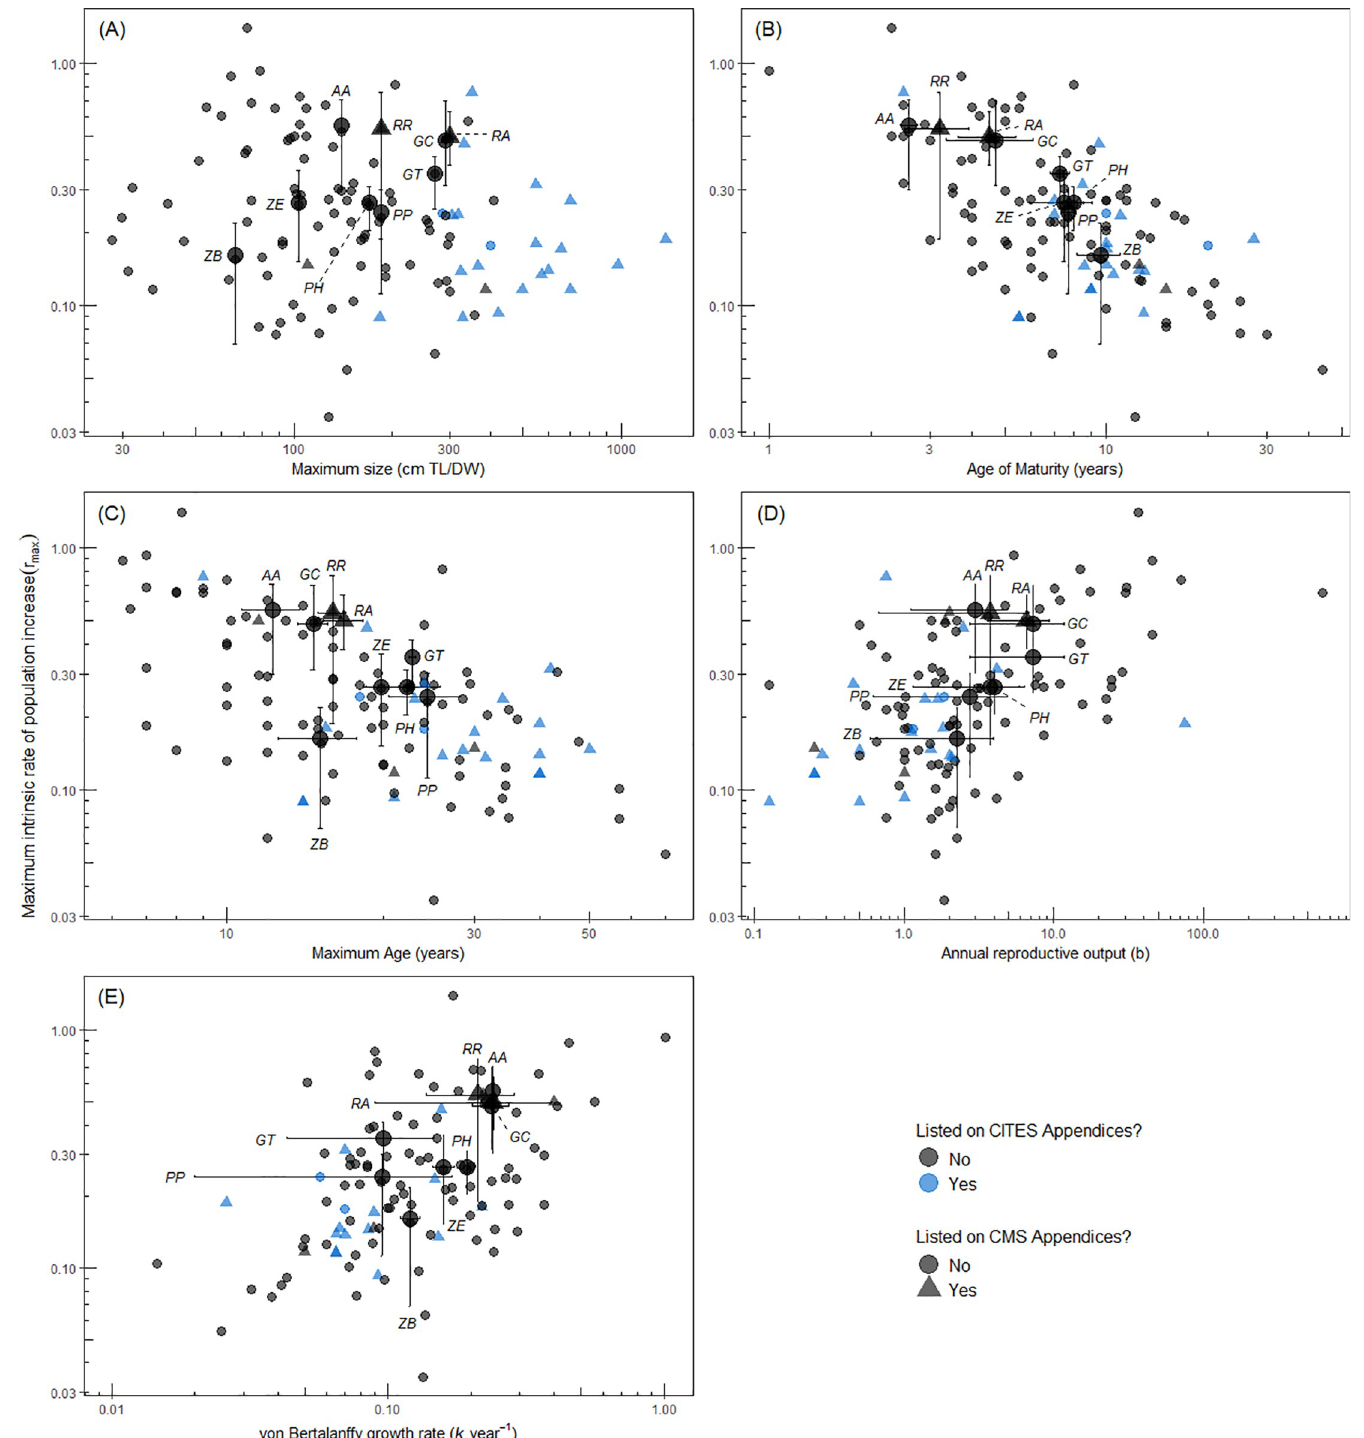
Fig 6. Estimates of r max for 115 chondrichthyans, including the nine shovelnose rays species, compared with life history parameters. (A) maximum size (cm TL/ DW), (B), age at maturity ( α years), (C) maximum age ( α , years), (D) annual reproductive output b , (E) the von Bertanlaffy growth coefficient ( k , year -1 ). The nine mat max shovelnose ray species labelled are: RA, R . australiae; GC, G . cemiculus ; GT, G . typus ; AA, A . annulatus; PH, P . horkelii ; PP, P . productus; RR, R . rhinobatos , ZB, Z . brevirostris; ZE, Z . exasperata . The black lines encompass 95% of the values (2.5 and 97.5% quantiles). The median r max value is reported, using the reciprocal of the lifespan method to estimate natural mortality. All axes are on a logarithmic scale. Species that are listed on CITES Appendix I or II are represented in blue, species listed on CMS Appendix I or II are represented as triangles. Species that are listed on neither CITES or CMS are indicated as grey circles.